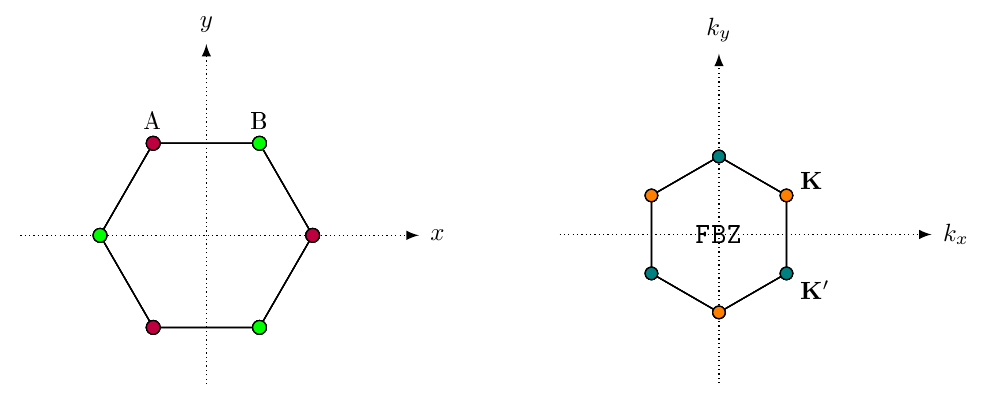
Figure 1 . Honeycomb lattice and (cid:12)rst Brillouin zone